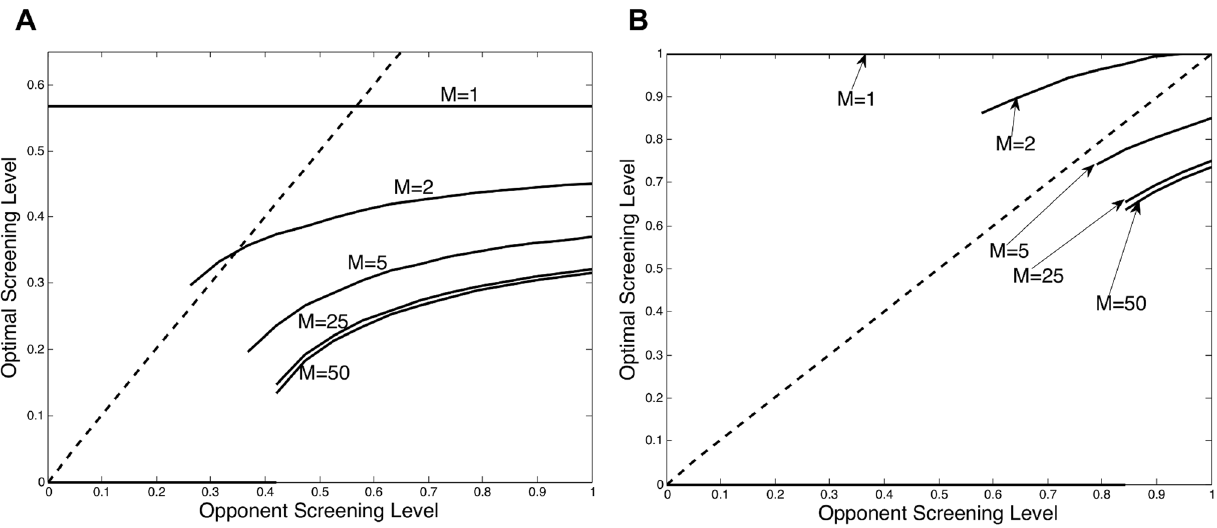
Figure 6. No screening equilibria. Under some disease parameter values, when treatment is less effective and the best response curve is upward sloping, increasing the degree of screening autonomy may lead a ‘‘no-screening’’ equilibrium, where institutions simply choose not to screening for disease. In both figures, screening takes place at a positive value when the level of screening autonomy is low ( M ƒ 2 ) but no screening occurs as autonomy increases ( M § 5 ). In Figure A, decreasing autonomy from five to two DUs results in 35% of patients being screening instead of none, while in Figure B, the same decrease in autonomy results in all patients being screened.